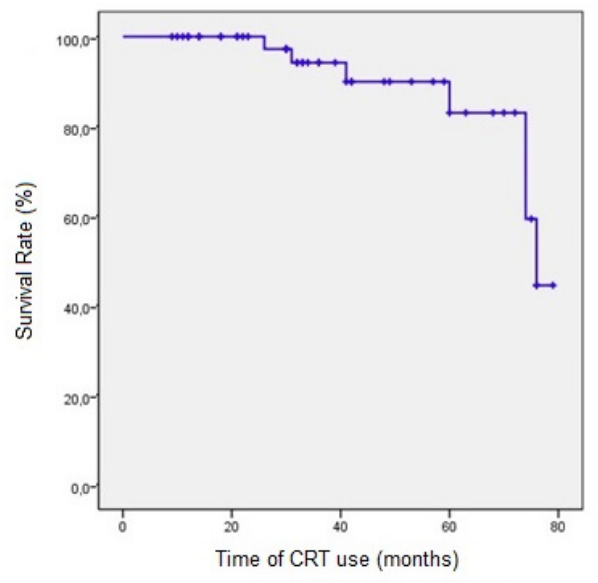
Fig. 3 – Kaplan-Meier estimates of survival for cardiac resynchronization therapy (CRT) responder patients.